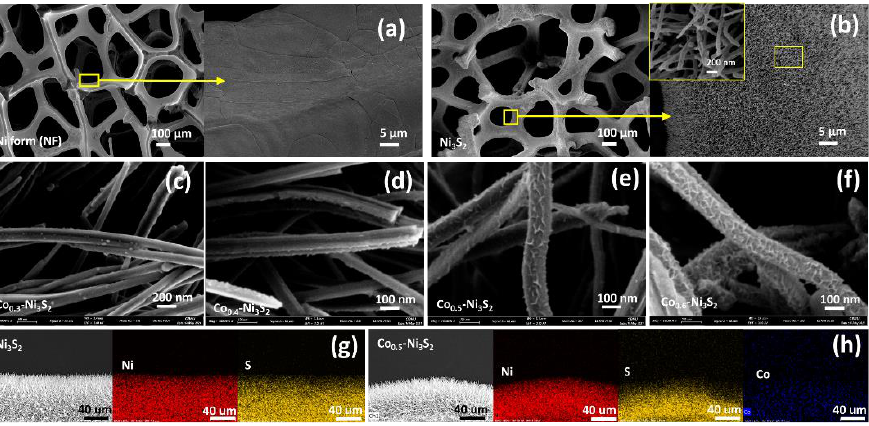
Figure 3. FE-SEM images at different magnifications and EDS mapping of ( a ) NF, ( b ) Ni 3 S 2 , ( c ) Co 0.3 – Ni 3 S 2 , ( d ) Co 0.4 –Ni 3 S 2 , ( e ) Co 0.6 –Ni 3 S 2 , ( f ) Co 0.6 –Ni 3 S 2 , ( g ) Ni 3 S 2 , and ( h ) Co 0.5 –Ni 3 S 2 .